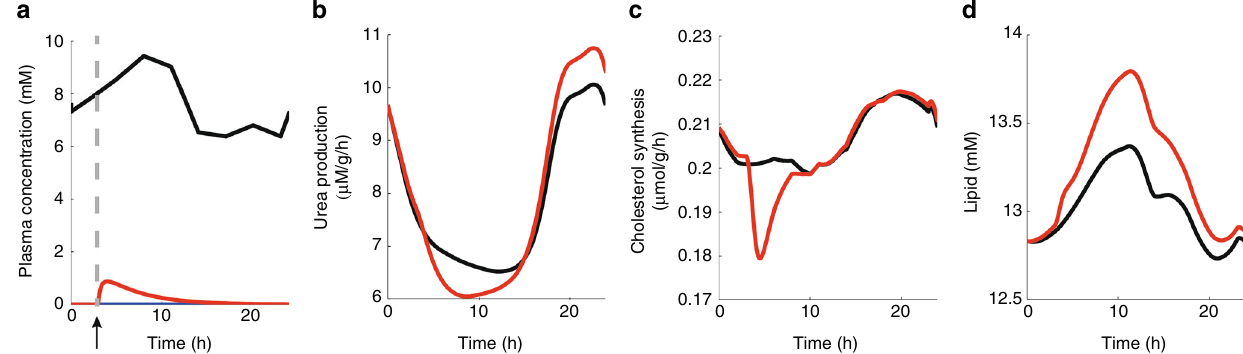
Fig. 7 Metabolic effects of a single dose of valproate. a 24 h plasma glucose pro fi le of the rat (black curve) and plasma pro fi le of VPA after a bolus given at t = 2 h (red curve) adopted from 38 as the detoxi fi cation of VPA by the microsomal CYP system is not part of the model. b Urea production rate. c Synthesis rate of cholesterol. d Cellular triglyceride content. Black curves refer to the reference case in the absence of VPA